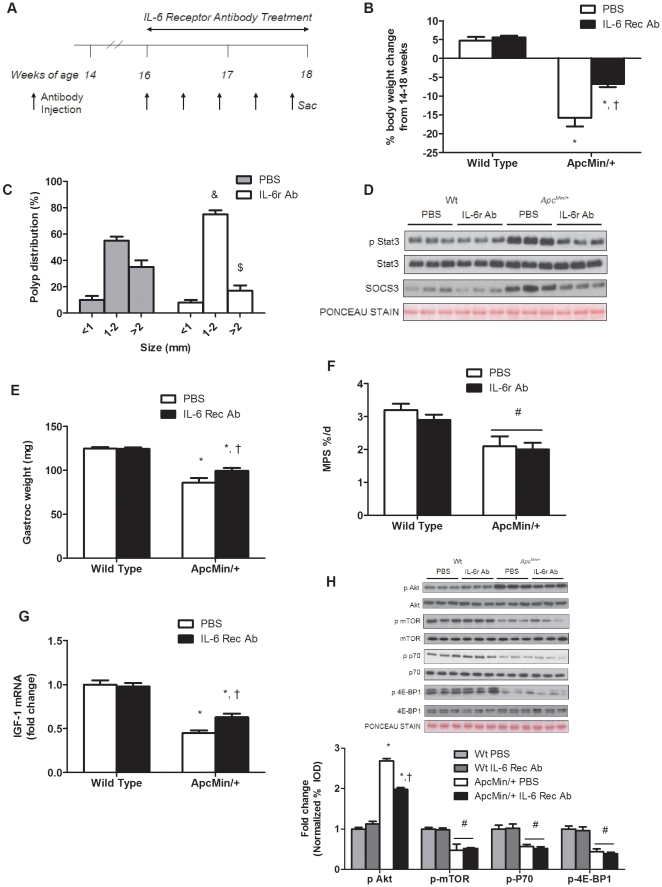
Inhibition of IL-6 signaling attenuates the progression of cachexia independent of changes in protein synthesis.Wild type and ApcMin/+ mice were given an IL-6 receptor antibody or PBS control at 16 weeks of age and sacrificed at 18 weeks. A) Experimental design showing administration schedule and time line of IL-6 receptor antibody or PBS treatment. B) Percentage body weight change from peak body weight to sacrifice weight. C) Polyp distribution presented in percentage of total tumors. D) Representative western blot of phosphorylated and total forms of Stat3 and total SOC3 protein expression. E) Gastrocnemius weight and F) muscle protein synthesis measured at sacrifice. G) IGF-1 gene expression in the gastrocnemius muscle. H) Upper: Representative western blots of phosphorylated and total forms of Akt, mTOR, p70S6K, and 4E-BP1. Lower: The ratio of phosphorylated to total form of the given protein normalized to PBS treated wild-type mice. Values are means ± SE. Significance was set at p<0.05. *Signifies difference within treatment. † Signifies difference within genotype. # Signifies main effect of genotype. & Signifies difference in polyps 1–2 mm. $ Signifies difference between polyps >2 mm.